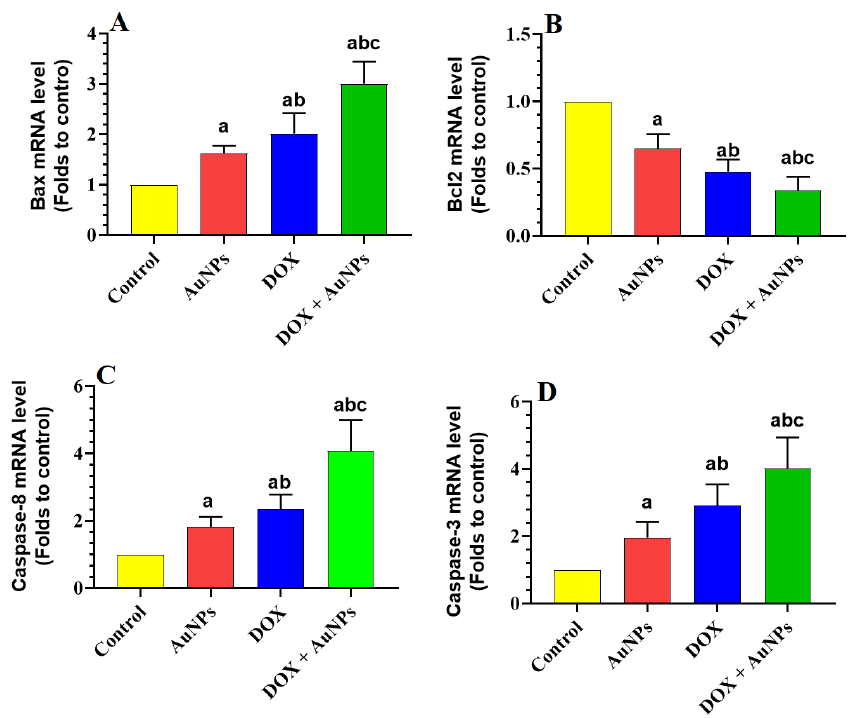
Figure 1. Effects of the individual or combined treatments with gold nanoparticles (AuNPs) and/or doxorubicin (DOX) on the transcription of some selected apoptotic and anti-apoptotic markers in the liver of all experimental groups. ( A ): Bax mRNA, ( B ): Bcl2 mRNA, ( C ): Caspase-8, and ( D ): Caspase-3. Data were analyzed by 1-way ANOVA followed by Tukey’s test. Values are presented as means ± SD ( n = 8/group). Significance was considered at p < 0.5. a : vs. control rats; b : vs. AuNPs-treated